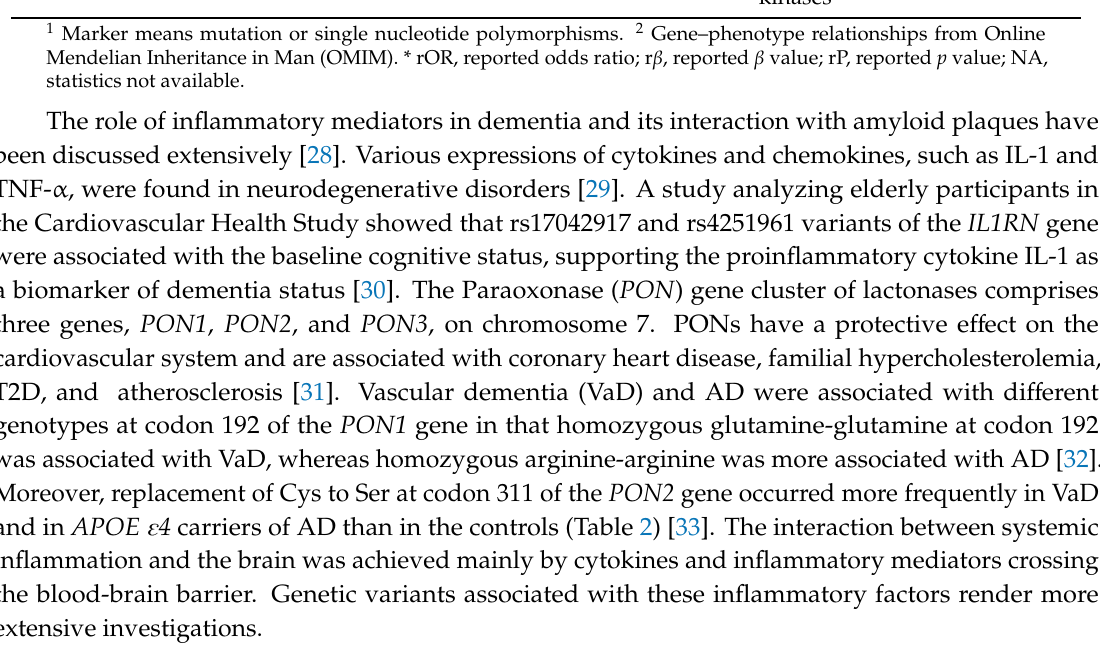
Table 2. Genes Associated with Hypercholesterolism, Hypertension, Inflammation, and Dementia.